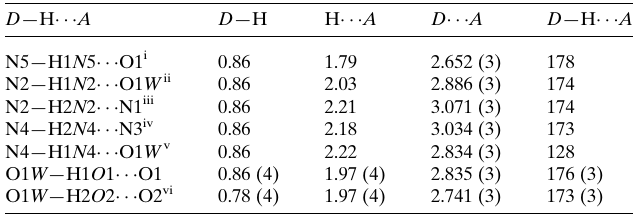
Table 1 Hydrogen-bond geometry (A˚ , (cid:4) ).